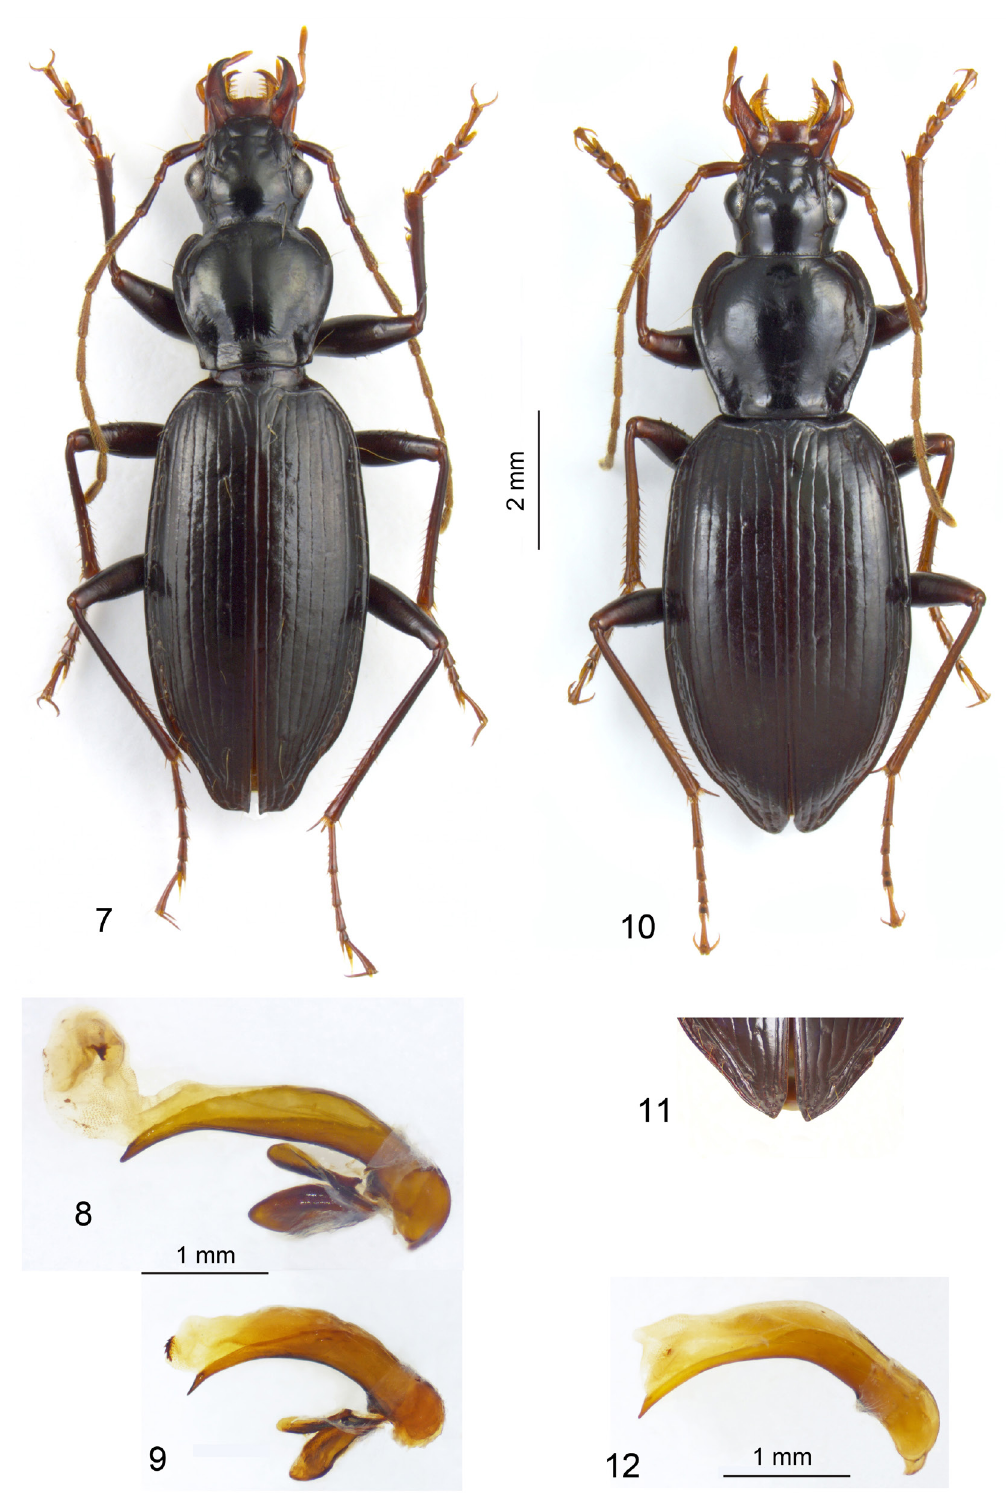
Figs 7–12. 7–8 . Dyscolus aquator Moret sp. nov. 7 . Habitus of the male holotype (QCAZ). 8 . Aedeagus, median lobe in lateral view. 9–10 . D. incommunis Moret sp. nov. 9 . Aedeagus, median lobe in lateral view. 10 . Habitus of the male holotype (QCAZ). 11–12 . D. rivinus Moret sp. nov. 11 . Apex of the elytra. 12 . Aedeagus, median lobe in lateral